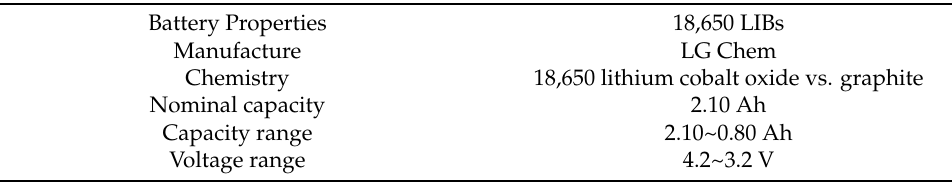
Table 1. Specifications of lithium–ion batteries.